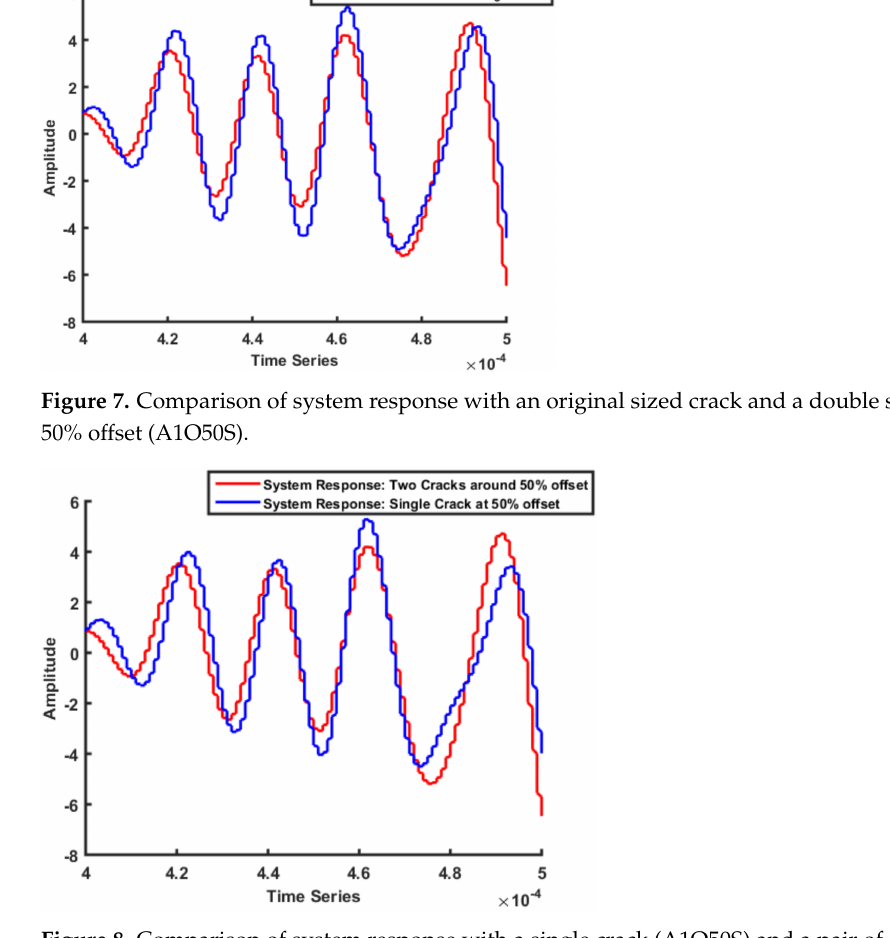
Figure 8. Comparison of system response with a single crack (A1O50S) and a pair of cracks at 50% offset (A1O50M).